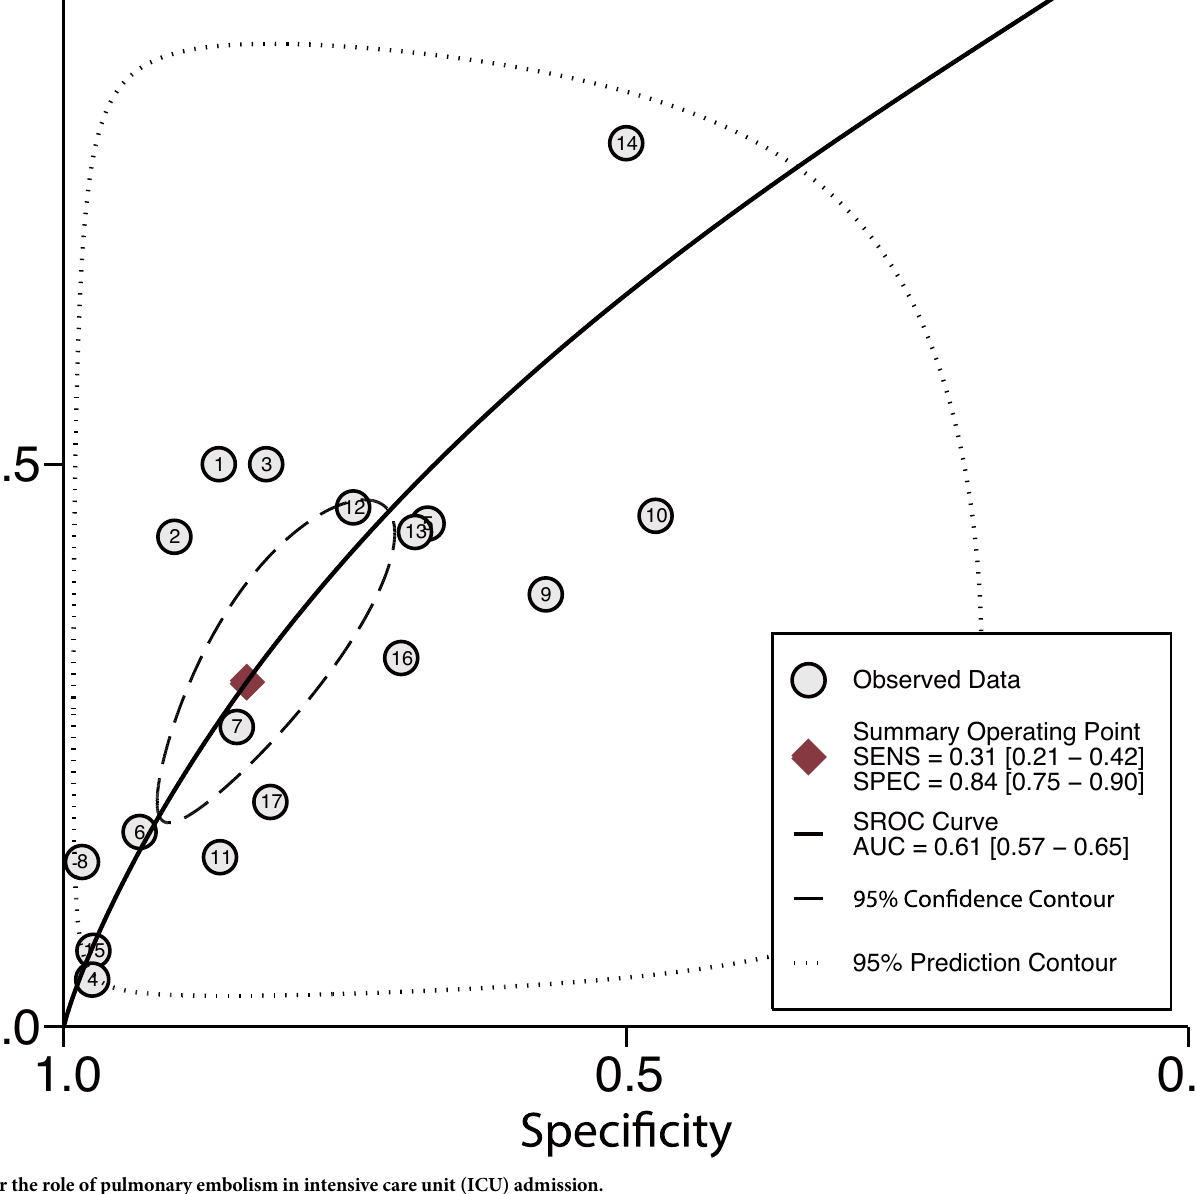
Fig 6. AUC for the role of pulmonary embolism in intensive care unit (ICU) admission.